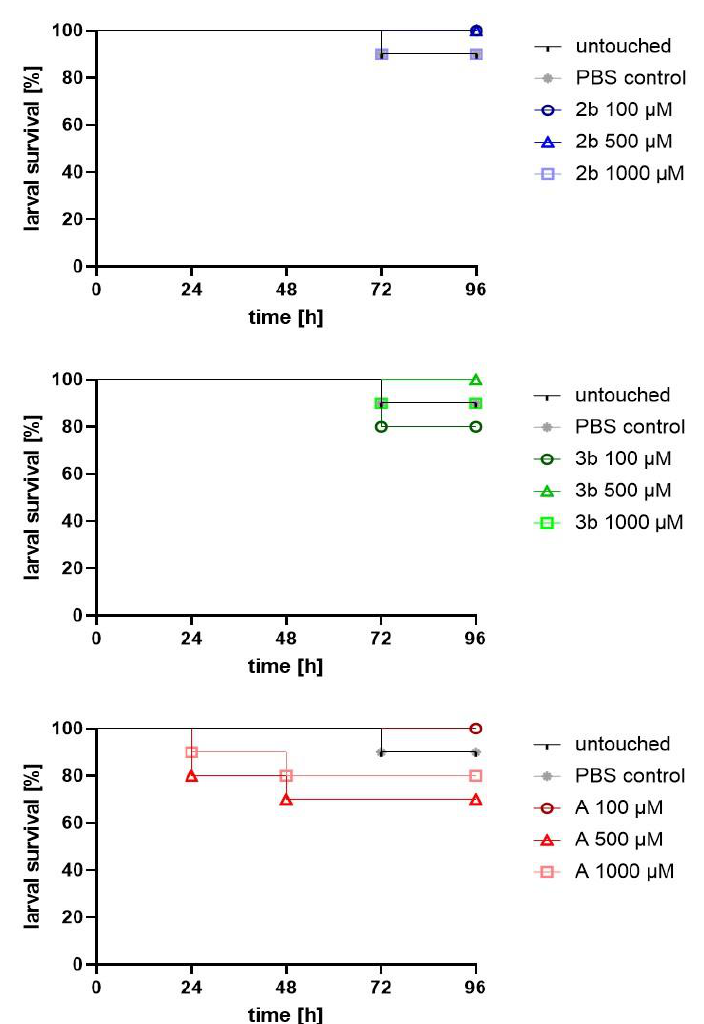
Figure 2. Impact of antifungal compounds 2b , 3b and amorolfine hydrochloride ( A ) on the survival of Galleria mellonella larvae. The Kaplan Meyer curves represent average survival rates of 40 larvae per sample (2 independent experiments). Each larva was injected with 20 µ L of the respective antifungal solution, and dilutions were made in PBS. Untouched larvae and larvae injected with PBS served as controls. Test compound concentration was chosen according to MIC data: 100 µ M represents the MIC/g larvae for 2b and 3b ; 500 µ M, the MIC for amorolfine hydrochloride; and 1000 µ M 10-fold, the MIC of 2b and 3b .